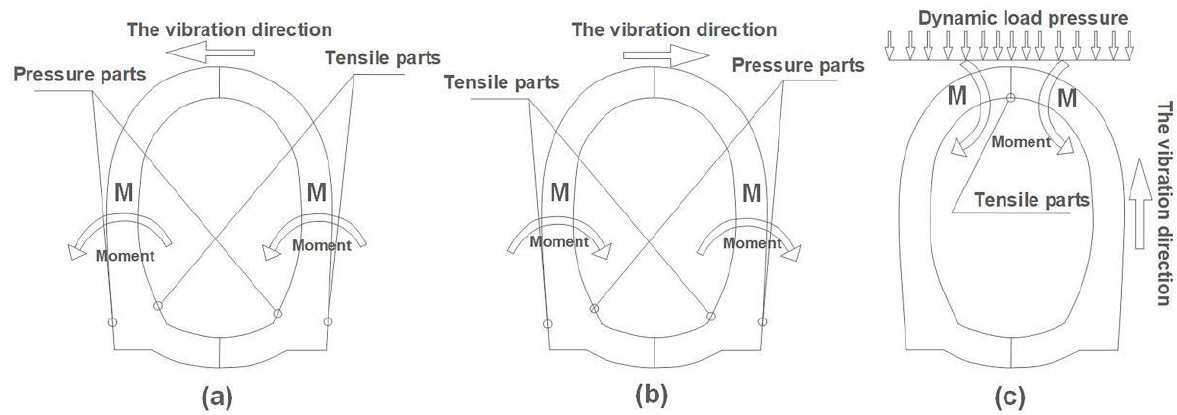
Figure 12. The schematic force diagram of tunnel model subjected to dynamic load in horizontal and vertical directions. ( a , b ) Vibration load in horizontal direction; compressive stress and tensile stress parts appear inside and outside the arch foot. ( c ) Vibration load in vertical direction; tensile stress part appears inside the vault.